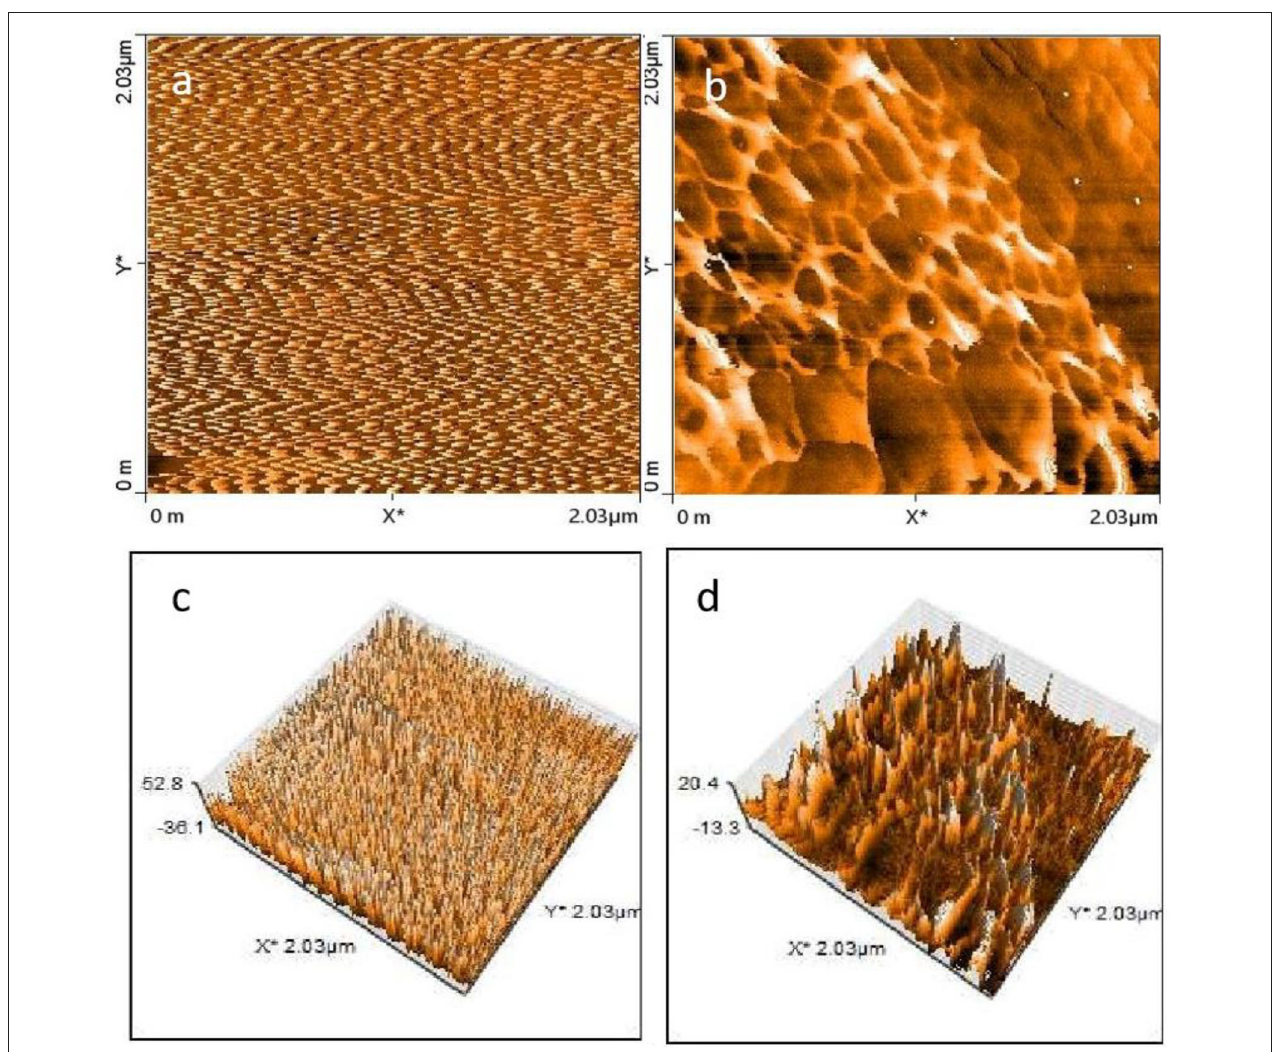
FIGURE 4 | AFM images 2D scan of (a) PI (b) Laser treated LRPI (c) 3D AFM scan of PI (d) Laser treated LRPI.